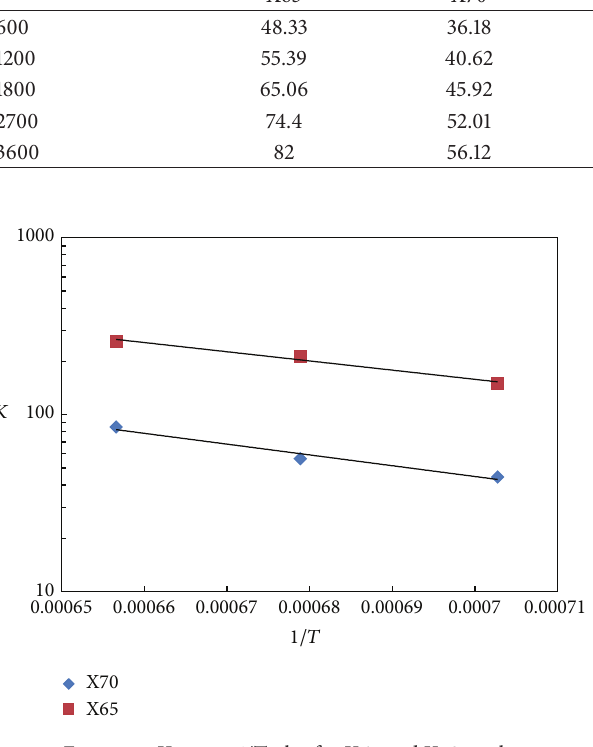
Table 2: Grain size ( 𝑑 , 𝜇 m) of X65 and X70 grades with reheating time. Holding time, s